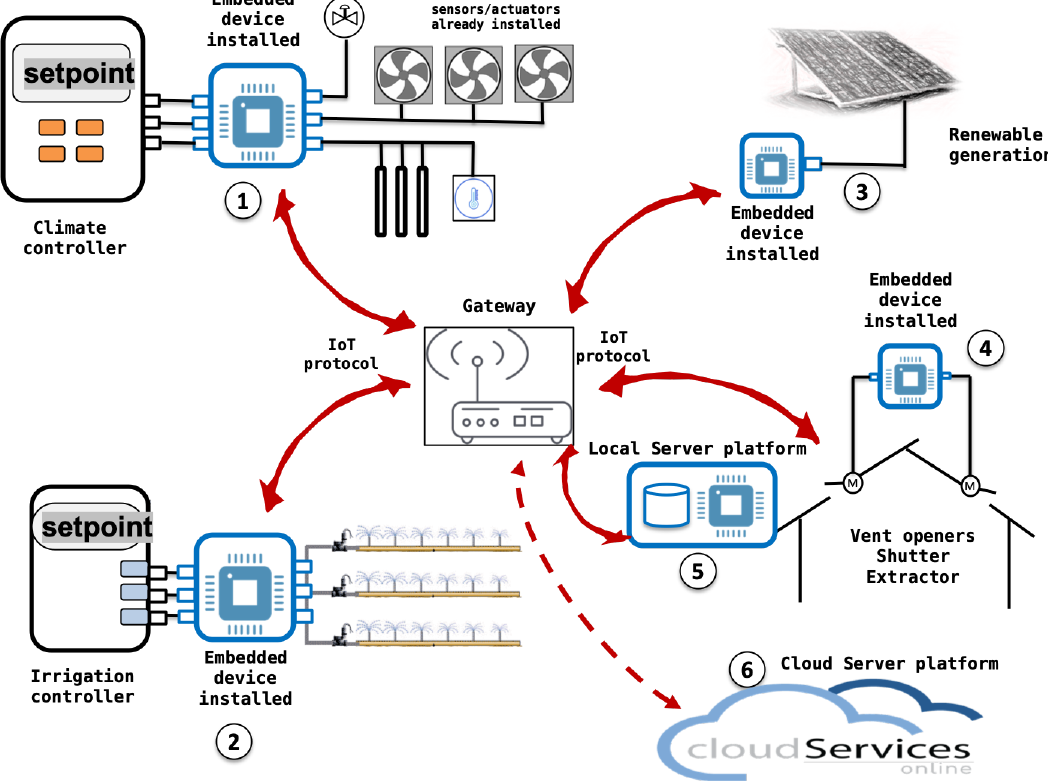
Figure 2. Architecture based on embedded controllers (control nodes). These nodes provide integration capacity through communication with IoT protocols and development of AI applications implemented in each node. The server layer is used to develop services with higher processing requirements, for storage and cloud services, among